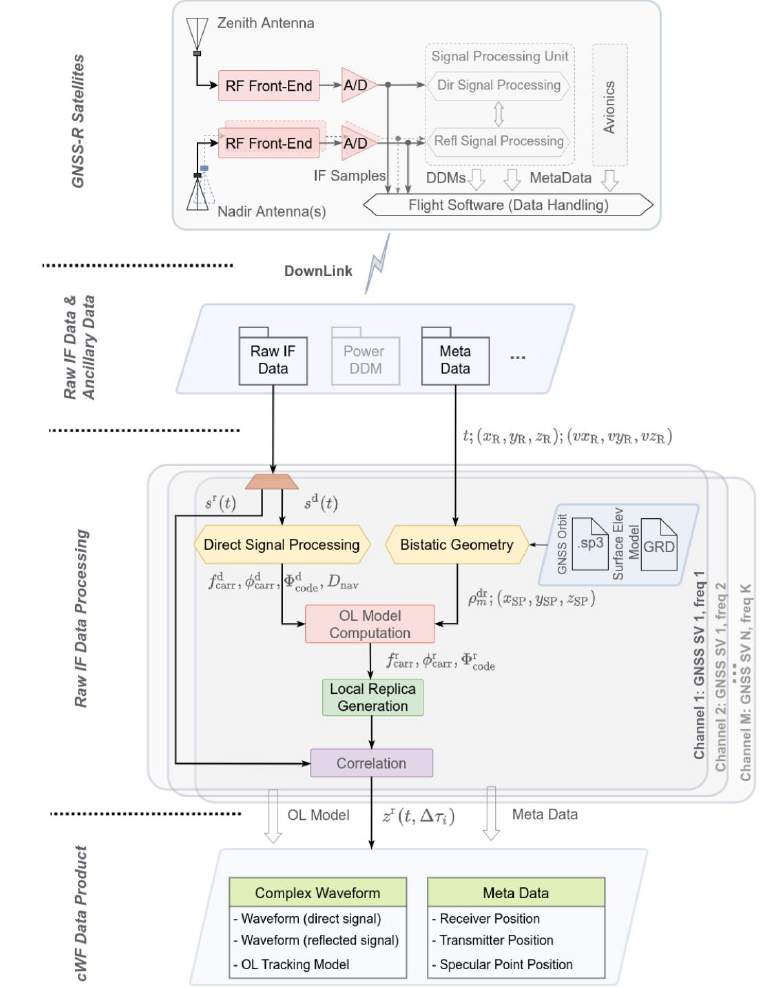
Figure 2. Collection and Processing Scheme of spaceborne GNSS-R Raw IF